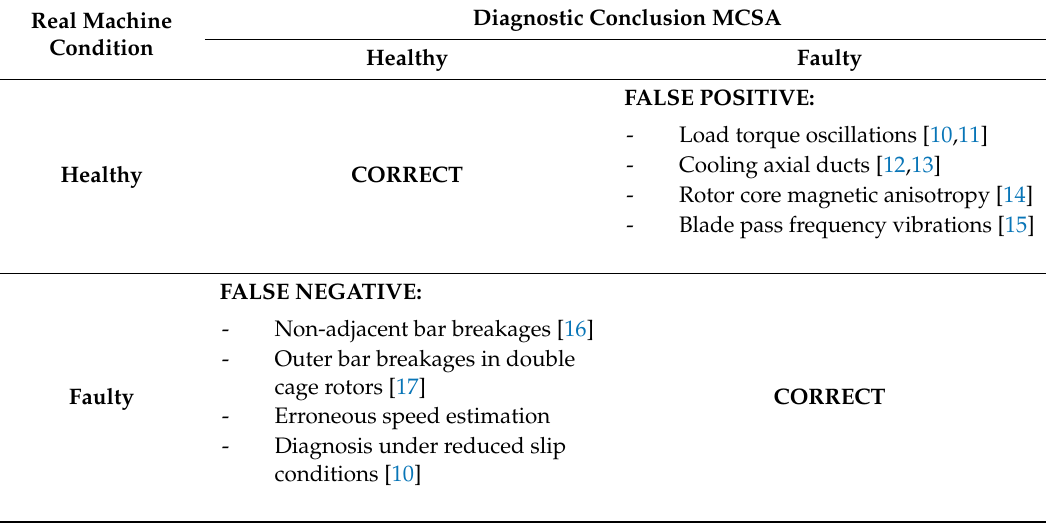
Table 1. Comparison between the diagnostic conclusion provided by Motor Current Signature Analysis (MCSA) and the real machine condition: sources of possible false positive and false negative